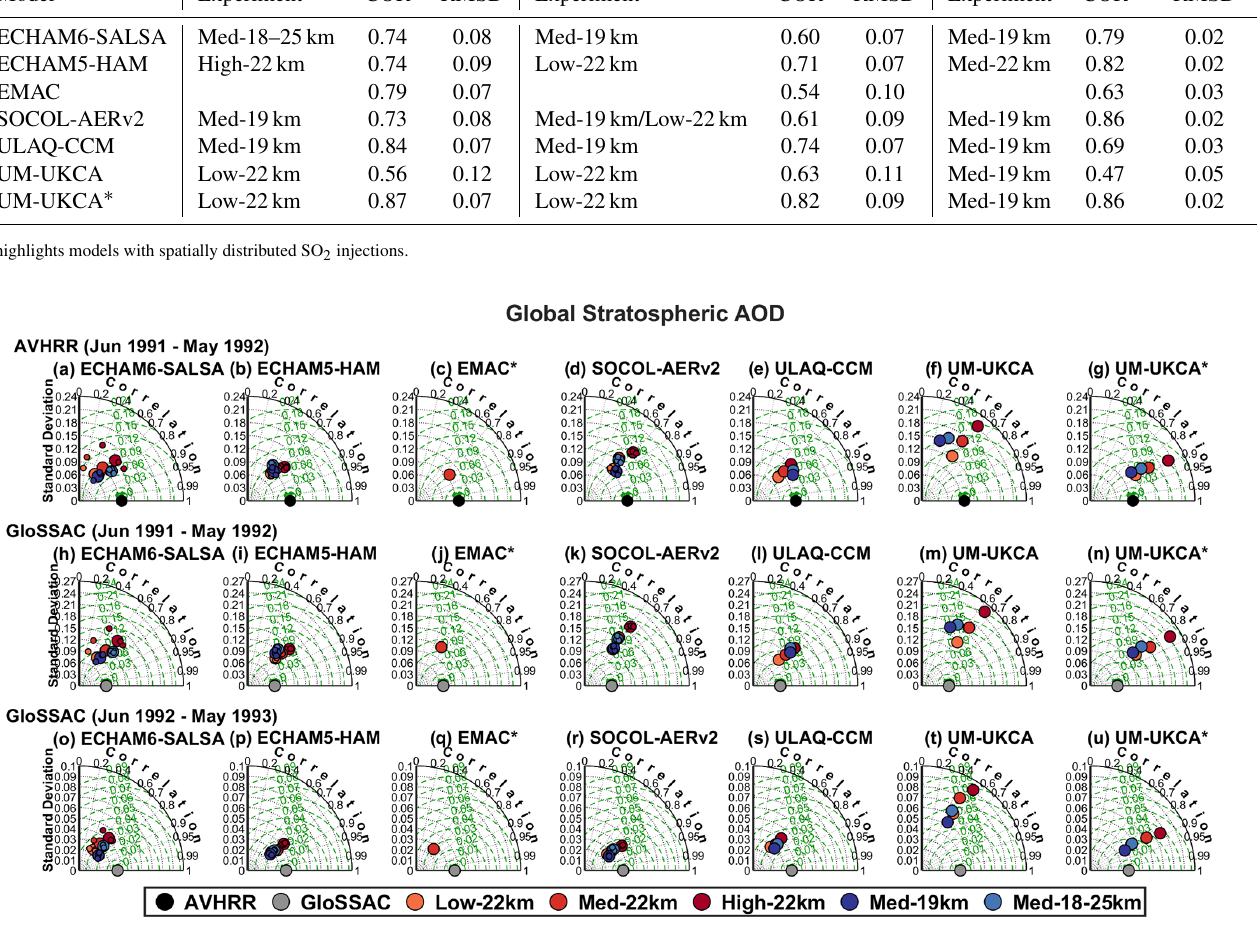
Figure 3. Taylor diagrams for the global stratospheric AOD. Zonal monthly mean values for different time periods have been used to calculate the standard deviation, correlation, and centered root-mean-square difference between model experiments and measurements. In the first row, model results are compared with respect to AVHRR over the period June 1991 to May 1992, in the second row with respect to GloSSAC over the period June 1991 to May 1992, and in the third row with respect to GloSSAC over the period June 1992 to May 1993 (See Appendix A1 for more details). ∗ Models with spatially spread SO 2